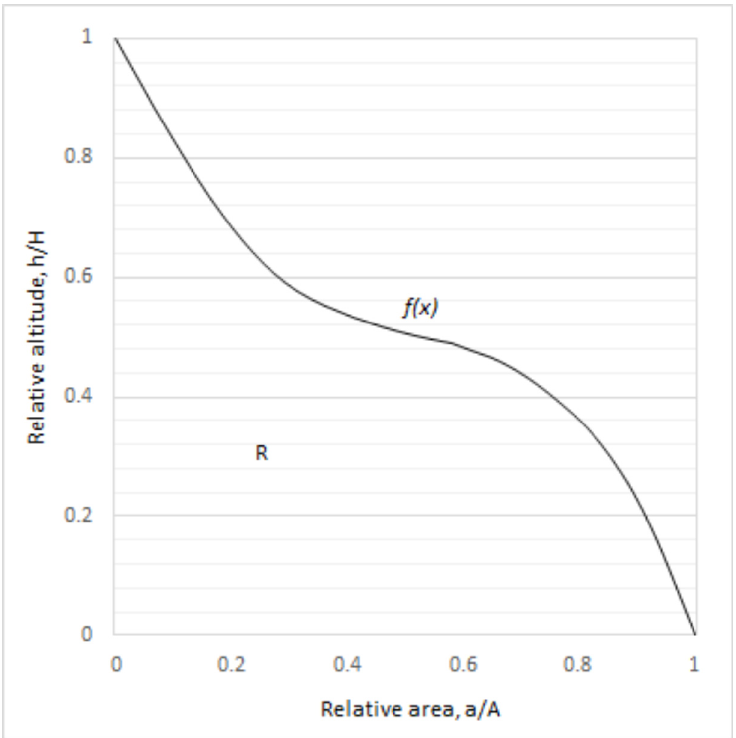
Figure 6. Hypsometric curve after Strahler [81]. The area of the region under a curve (R) is a hypsometric integral. A hypsometric curve is represented by function f(x), where the total elevation (H) is relief within the area (maximum elevation minus minimum elevation), total area (A) is the total surface area, and area (a) is the surface area above a given altitude (h).